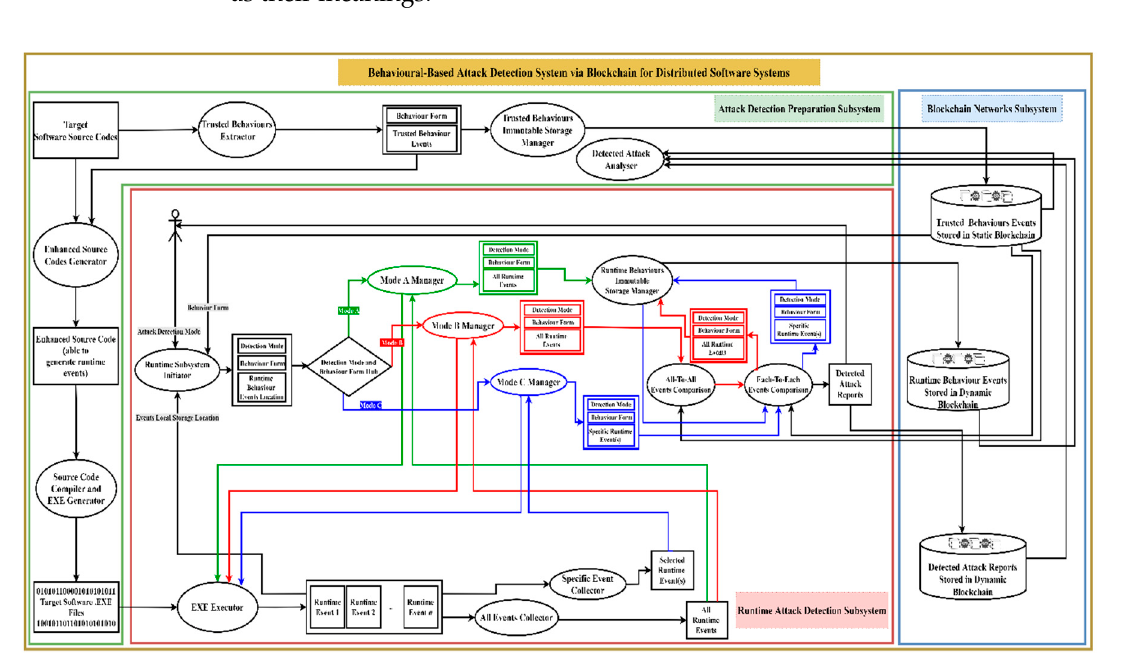
Table 4. Event’s body data structure.